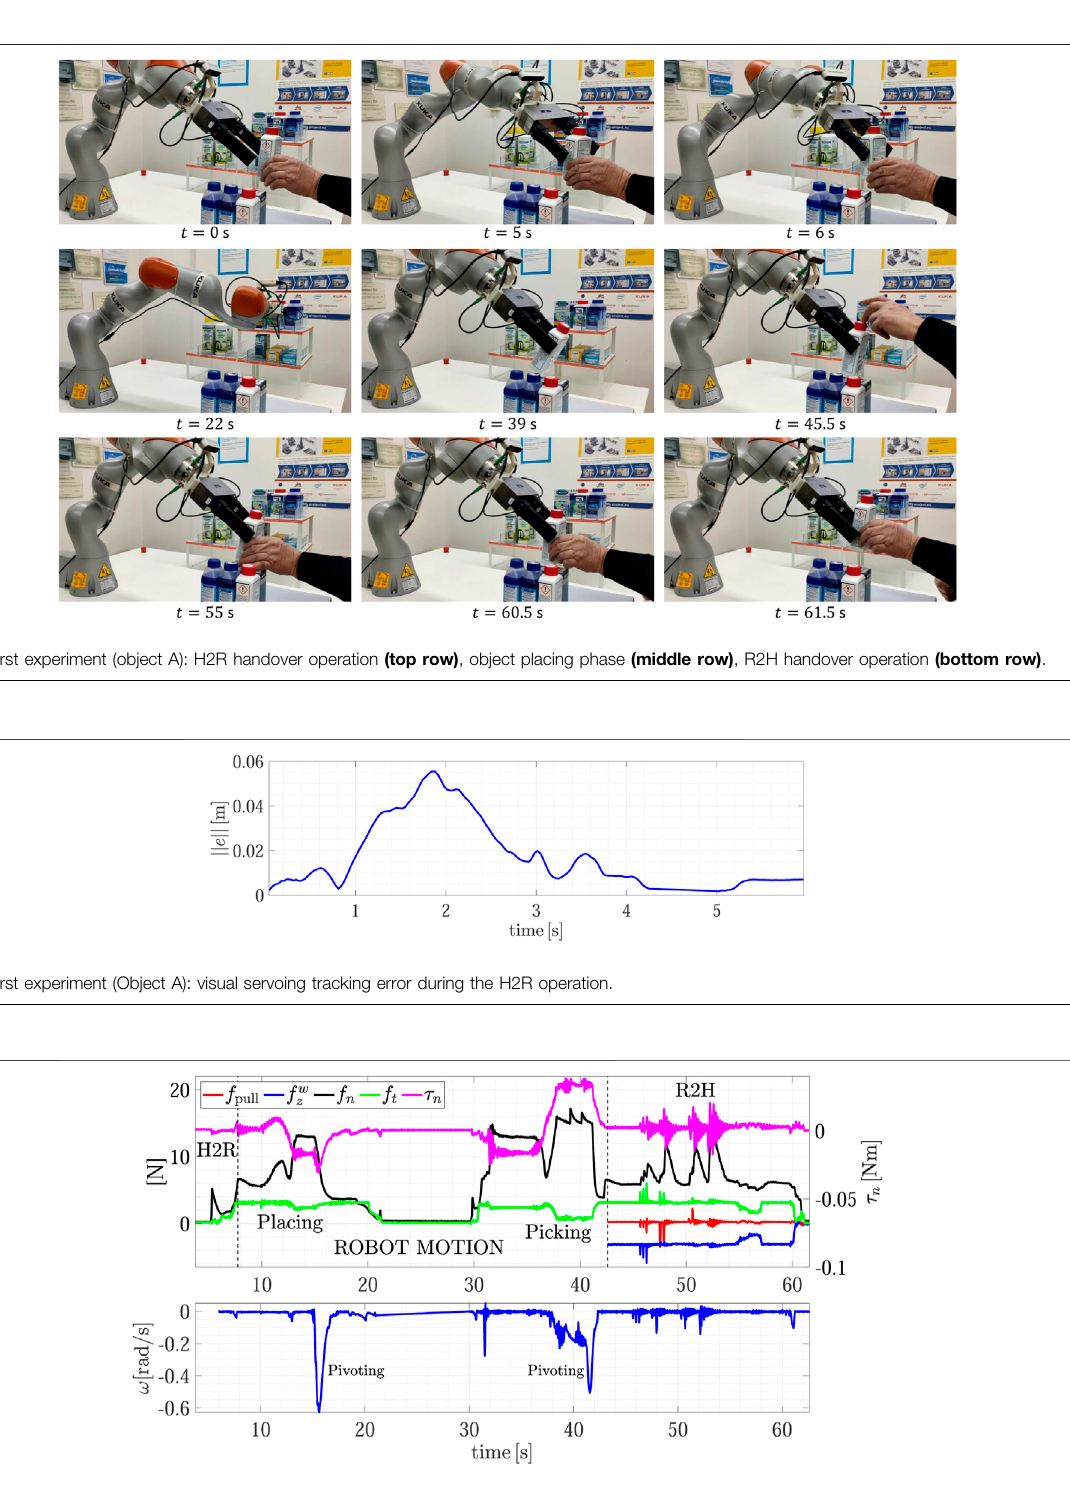
FIGURE7| Firstexperiment(ObjectA):forcesandtorsionalmomentmeasuredbytherobotduringthewholetaskexecution (topplot); estimatedslippingvelocity (bottom) .